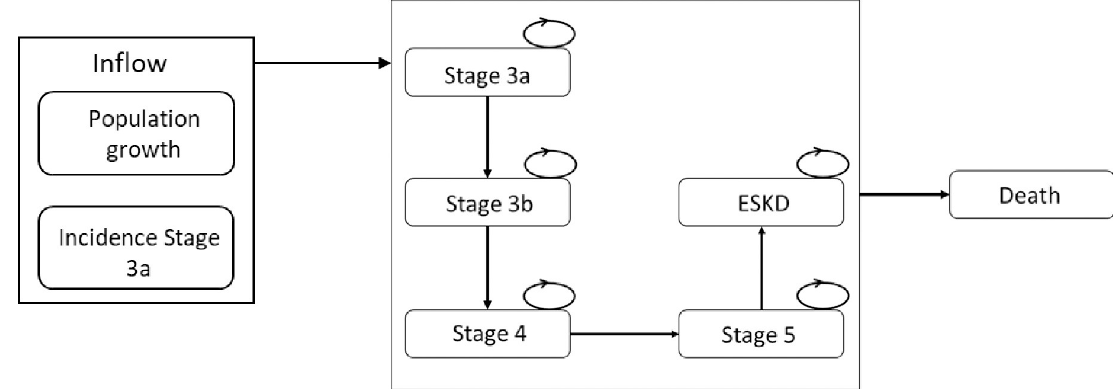
Fig 1. Dynamic stock and flow model. The inflow of the model was built based on the annual incidence of CKD stage 3a and the estimated growth in the Chilean adult population. The progression of CKD was determined by the estimated glomerular filtration rate (eGFR) levels calculated using the CKD-EPI equation. Progression could be decrements of 5, 3 or 1.4 ml/min/1.73 m 2 per cycle depending on the presence of diabetes and/or increased albuminuria. Patients can progress to another stage or remain in the same health state. Death could occur from any